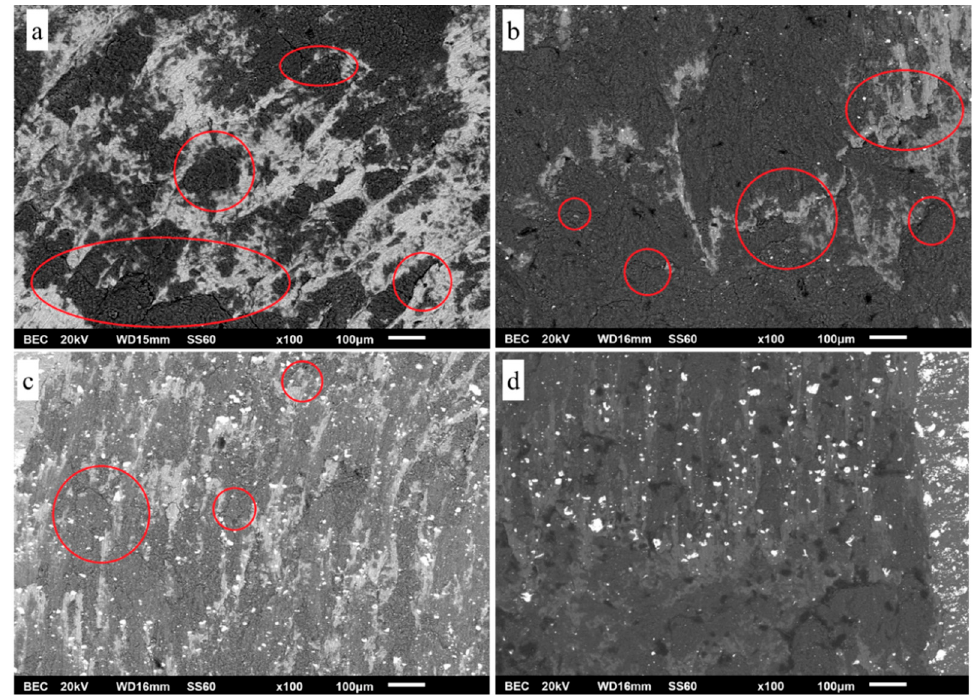
Figure 12. Wear tracks as acquired from SEM in higher magnification. Cracks flow is visible in monolithic specimen ( a ), and in 1 vol.% reinforced specimen ( b ). In 3 vol.% ( c ) and 5 vol.% ( d ) specimens cracks are fewer and less visible.